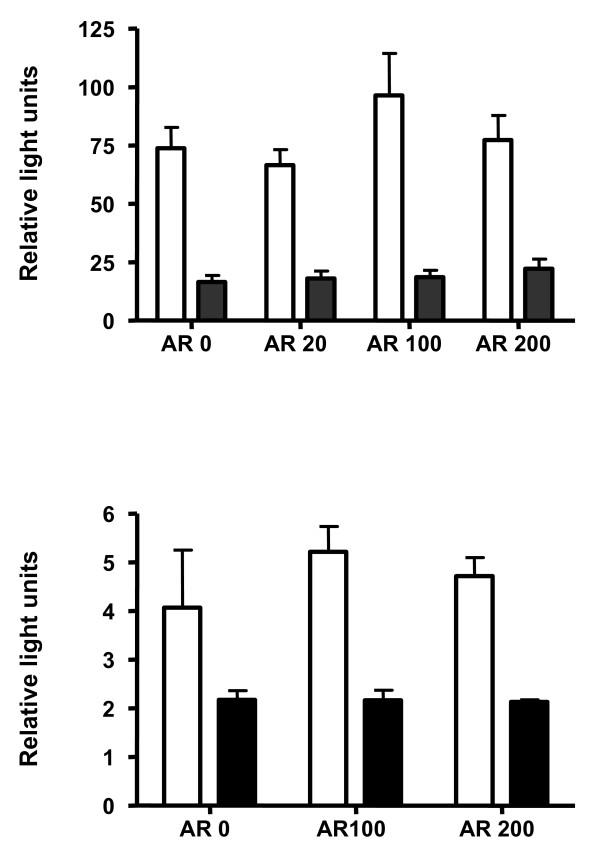
Increased androgen receptor expression does not block the inhibitory effect of C/EBPα on PSA promoter activity. LNCaP cells were co-transfected with 0, 10, 100, and 200 ng of androgen receptor cDNA in the presence (dark bars) or absence (open bars) of 100 ng cDNA for C/EBPα and in the presence of luciferase reporter construct driven by either the promoter/enhancer (upper panel) or PSA proximal promoter (lower panel). DHT was added at 50 nM and after 36 hrs the luciferase activity was measured. The results expressed as relative light units are the means ± standard deviation of 3 separate experiments.